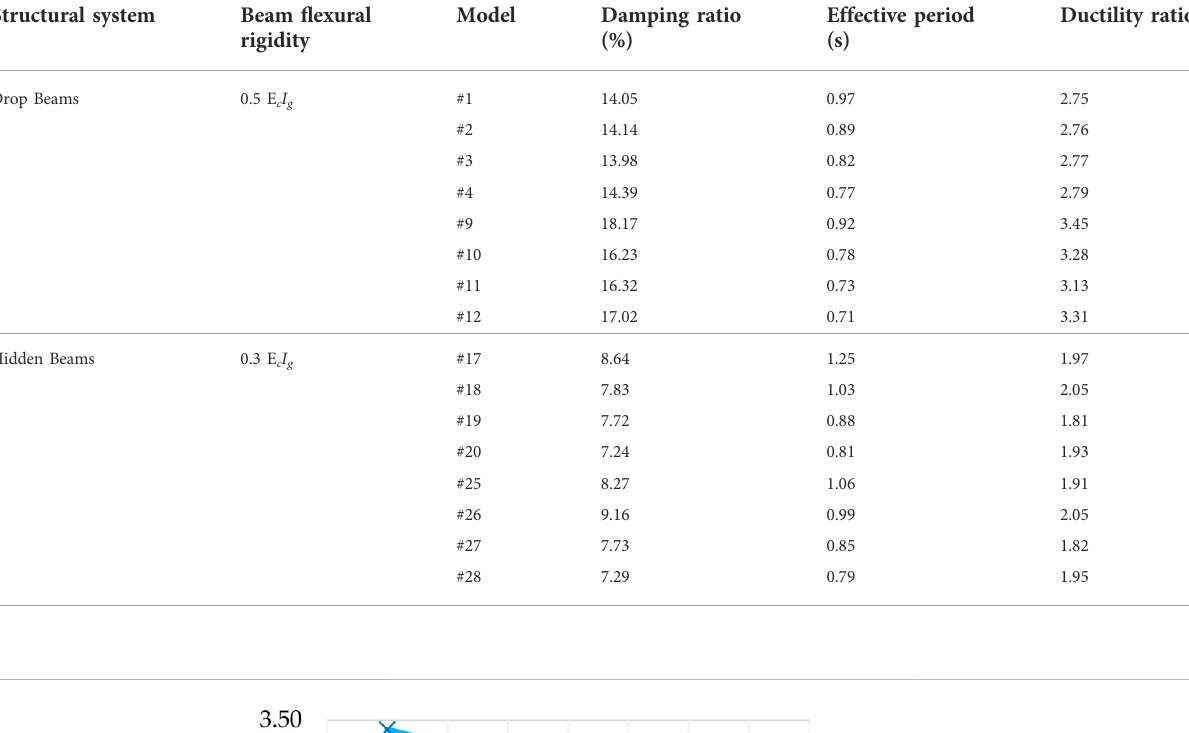
TABLE 10 FEMA 440 equivalent linearization results.